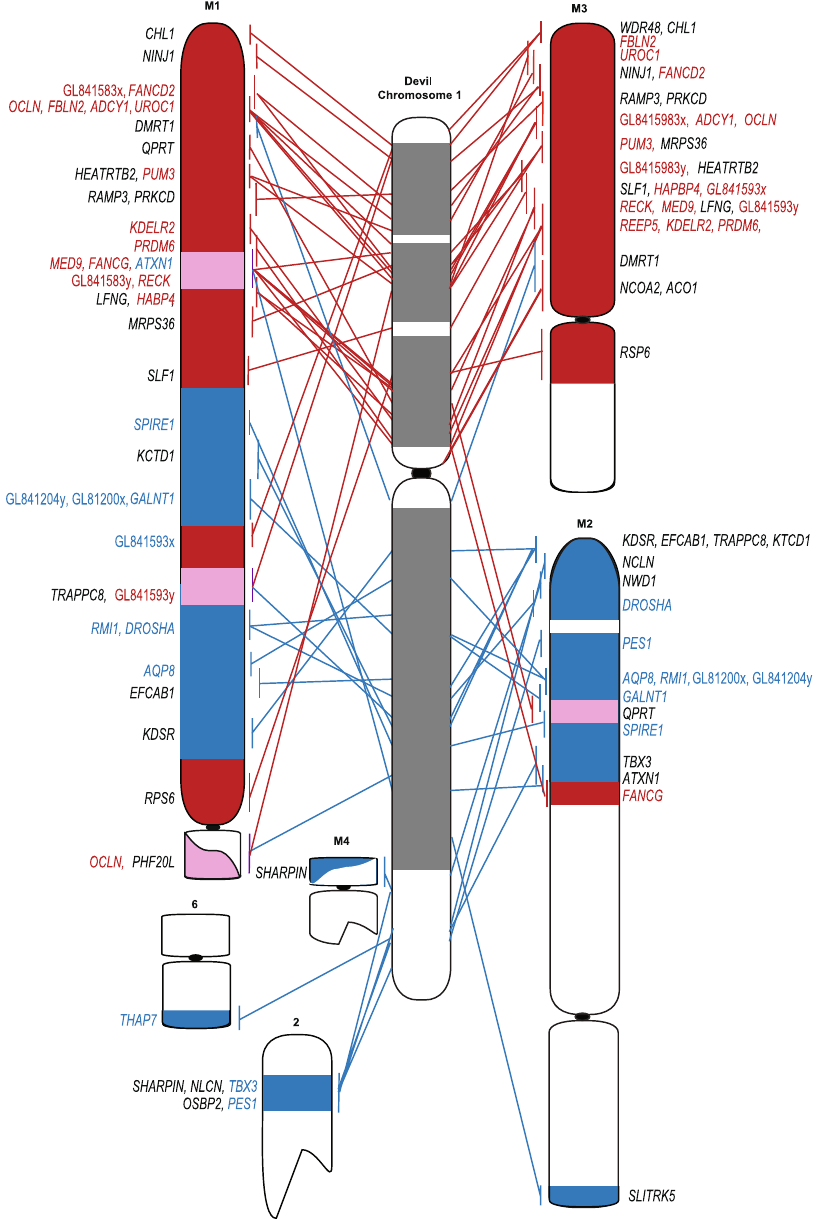
Figure 3. Comparison of consensus mapping data from three DFT1 strains with the location of genes on devil chromosome 1. Lines indicate the location of the genes on the normal devil chromosome 1 (DAPI banded chromosome indicated in the centre) compared to their location on DFT1 chromosomes. Regions of DFT1 chromosomes and lines indicating position of genes have been colour-coded red for devil 1p genes and blue for devil 1q genes. Regions containing genes from both chromosome 1 arms are indicated in pink. Genes mapped as part of this study are indicated in colour. Genes mapped previously 13 are in